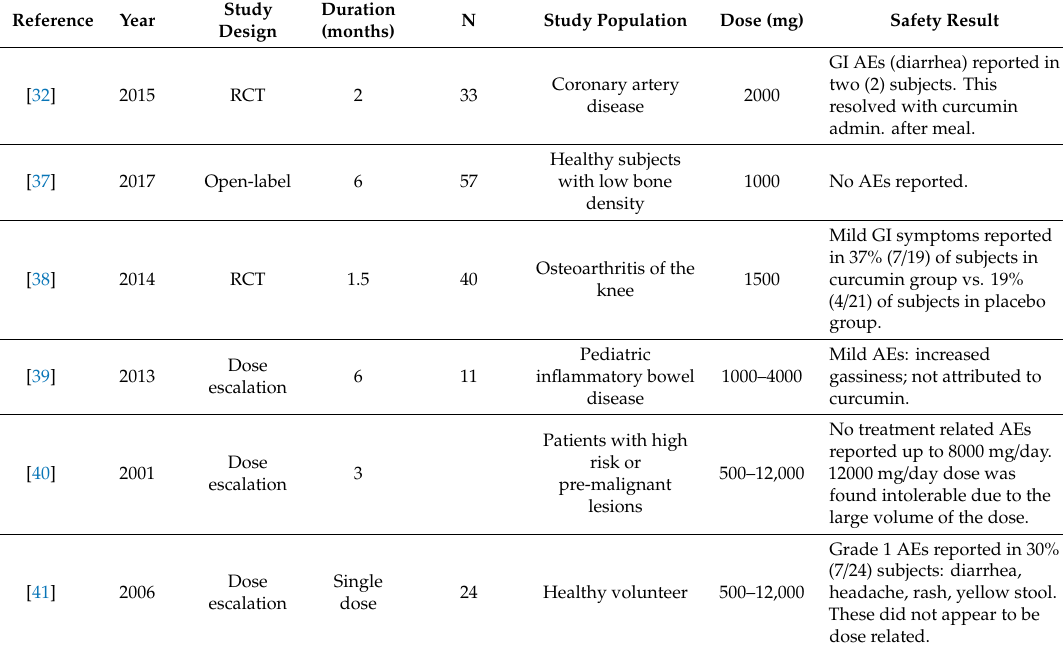
Table 1. Summary of Safety Profile of